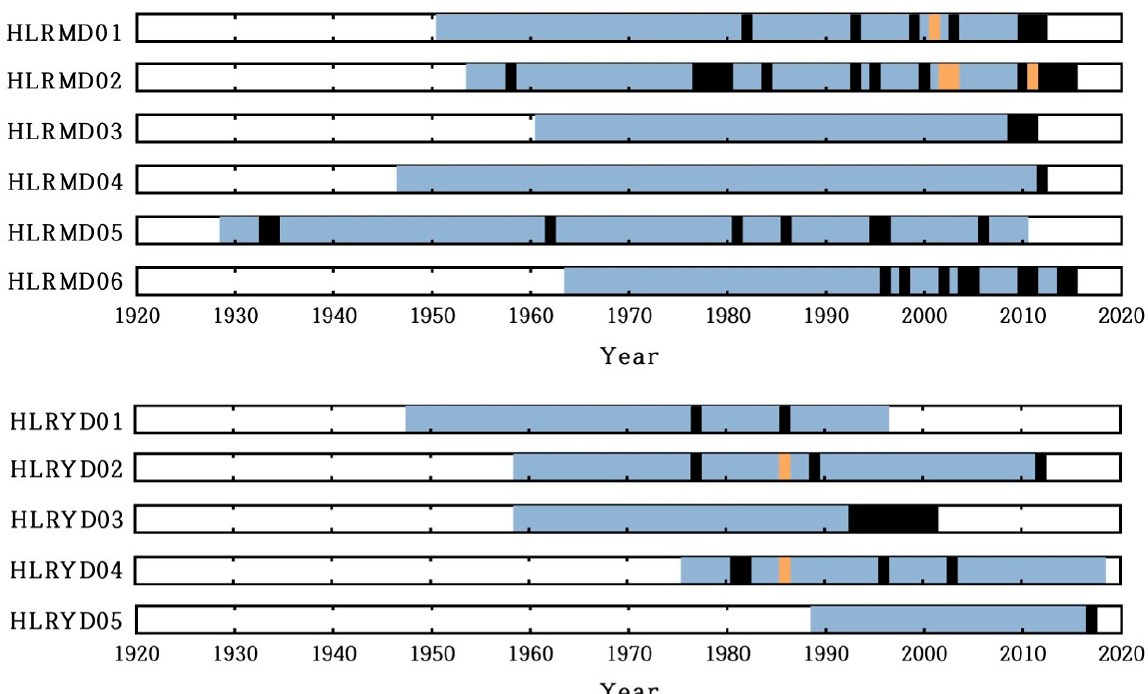
Figure 5. Missing (orange) and discontinuous (black) rings in individual dead shrubs (HLRMD: R. mucronulatum , HLRDL: R. yedoense ) and their frequency for each year (blue background: the length of time series).